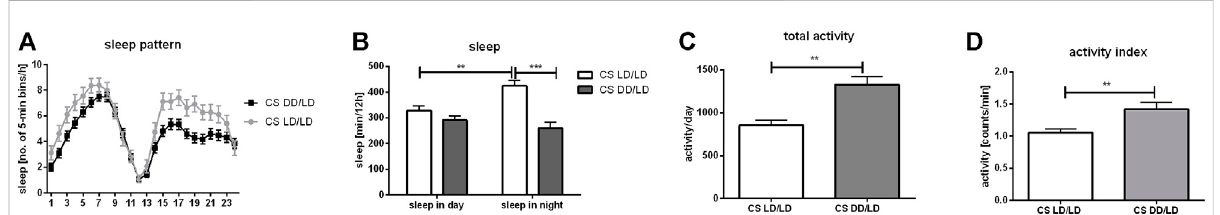
Light during embryonal/larval stage regulates sleep. Wild-type fl ies (Canton S, CS) were grown starting from embryo in LD12:12 or DD regime. After eclosion all fl ies were kept in LD12:12 and 2-days old males were used for DAMS locomotor analysis. Sleep and activity level were measured during second day of experiment. (A) Sleep pro fi le of fl ies (measured as number of 5-min beans per hour) maintained without light during early life (DD/LD) shows differences with control (LD/LD) during fi rst 8 h after light-on and during whole night. (B) Sleep time measured as number of minutes per 12 h showed that DD/LD group has decreased level of sleep during the night. Control fl ies show higher level of sleep during the night than during siesta, while experimental insects have similar level of sleep throughout the day. (C) Total activity measured as number of minutes